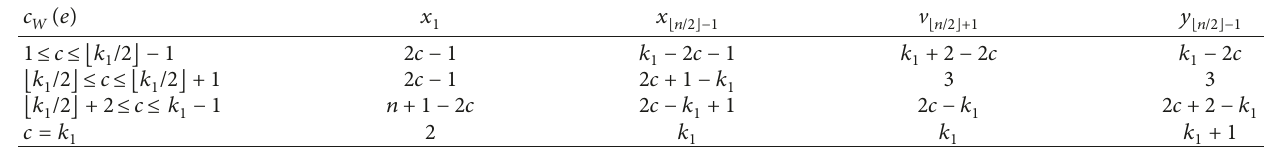
u c is even. c c , when